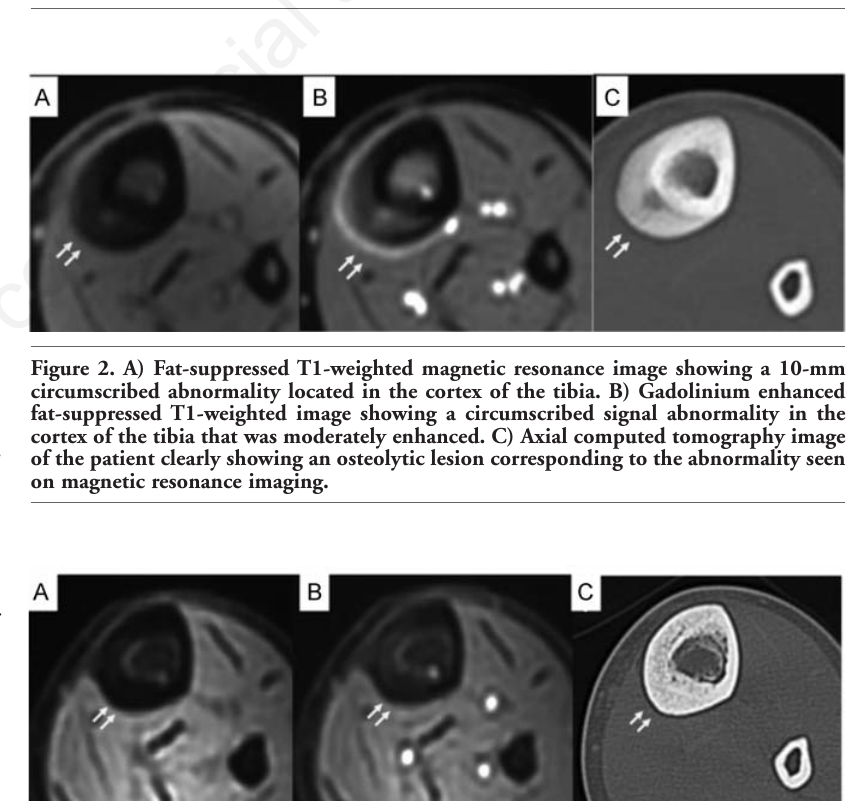
Figure 1. A) Anteroposterior radiographs showing a lucent zone and a surrounding scle- rotic zone in the middle third of the tibia. B) Direct coronal computed tomography scan showing a 10-mm circumscribed osteolytic area in the cortex of the tibia with surround- ing sclerosis. C) A bone scan showing an area of intense focal uptake with a surrounding area of lesser uptake, which is characteristic scintigraphic pattern of osteoid osteoma.